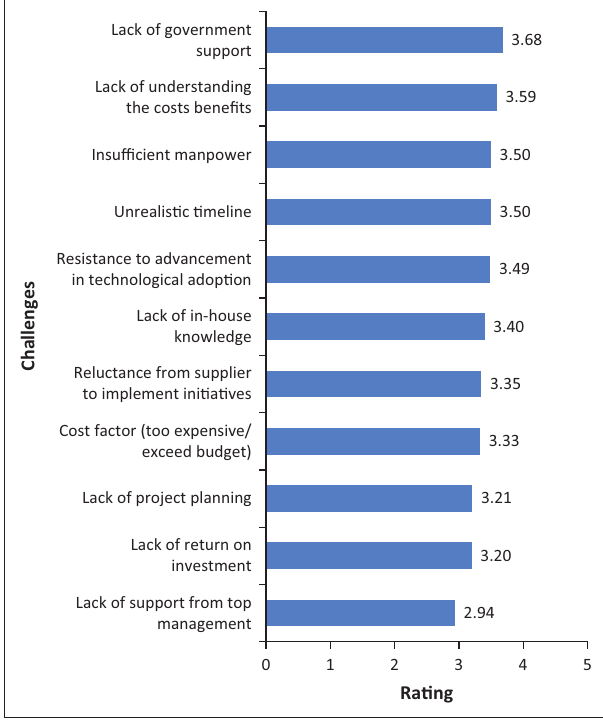
FIGURE 5: Challenges in implementing sustainable supply chain practices.